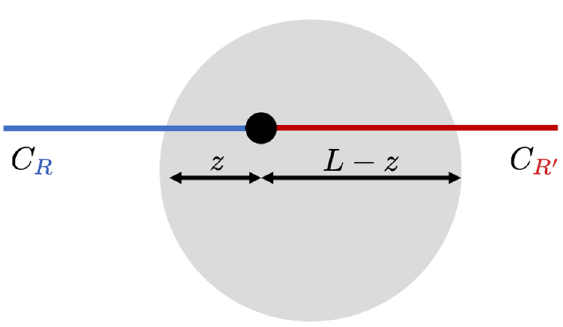
Figure 1 . Sketch of the nuclear broadening at small coherence